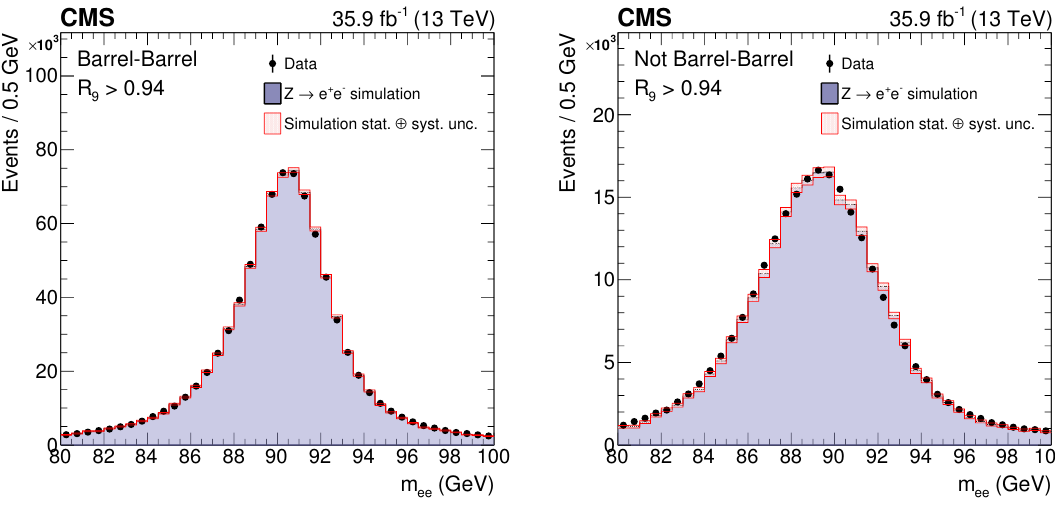
Figure 1 . Comparison of the dielectron invariant mass distributions in data and simulation (after energy smearing) for Z ! e + e (cid:0) events where electrons are reconstructed as photons. The compari- son is shown requiring R 9 > 0 : 94 for both \photons" and for (left) events with both photons in the barrel, and (right) the remaining events. The simulated distributions are normalized to the integral of the data distribution in the range 87 < m ee < 93 GeV to highlight the agreement in the bulk of the